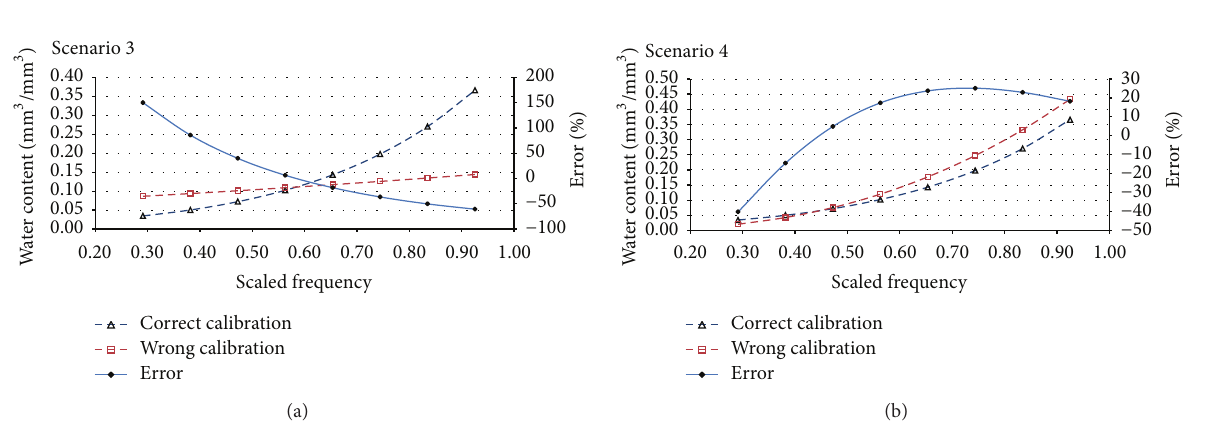
Figure 5: Comparison between calibrated and faulty readings of EnviroSCAN probe for Scenarios 3 and 4.